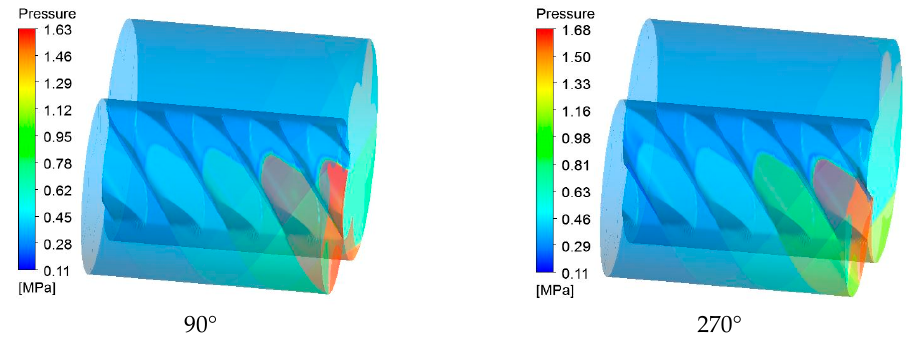
Figure 8. The pressure distribution of the intermeshing clearance of the rotors at different angles.